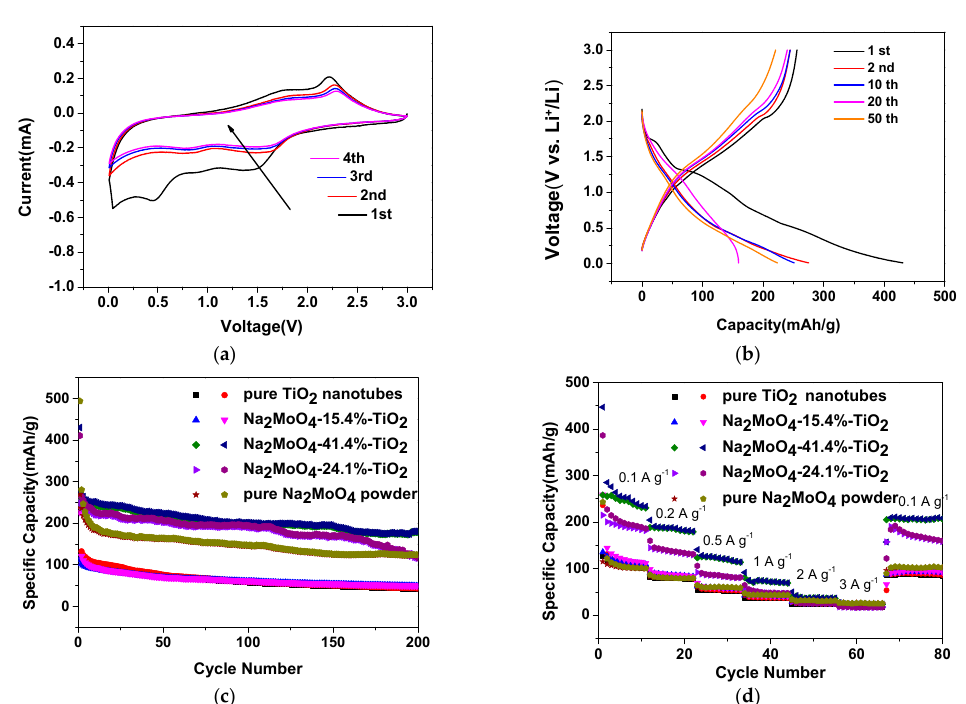
Figure 6. Electrochemical performances of the natural cellulose substance derived nanotubular Na 2 MoO 4 /TiO 2 composites when employed as anodic materials for lithium-ion batteries. ( a ) Cyclic voltammetry curves of the Na 2 MoO 4 – 41.4%-TiO 2 sample measured at a scan rate of 0.1 mV s − 1 over the potential window of 0.01–3.0 V vs. Li + /Li. ( b ) The charge – discharge profiles of the Na 2 MoO 4 – 41.4%-TiO 2 sample at the 1st, 2nd, 10th, 20th, and 50th cycles under a constant current density of 100 mA g − 1 between 0.01 and 3.0 V. ( c ) The cycling performances measured at a current density of 100 mA g − 1 and ( d ) the rate capabilities at various current densities of the nanotubular Na 2 MoO 4 /TiO 2 composites, pure TiO 2 nanotubes, and pure Na 2 MoO 4 powder.